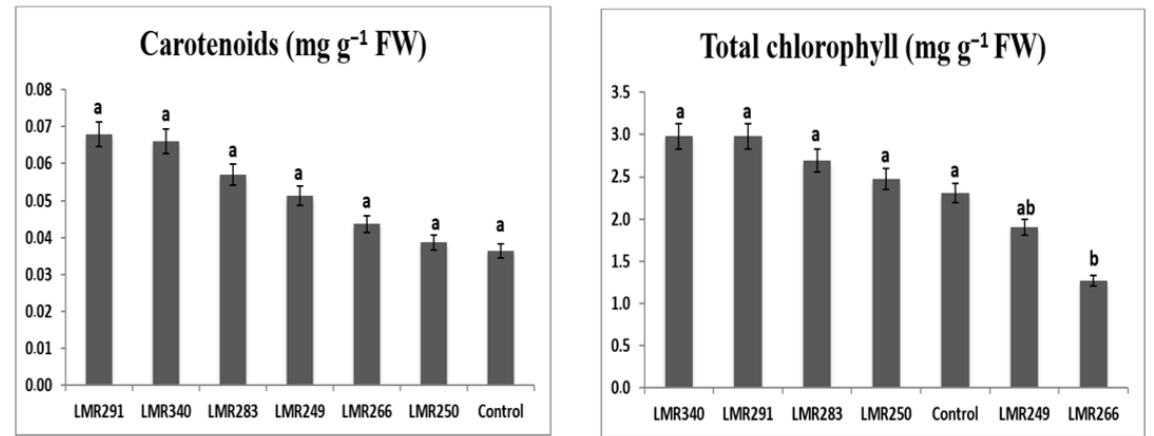
Figure 2. Total chlorophyll (mg g − 1 FW) and carotenoid (mg g − 1 FW) content of Sulla plants grown